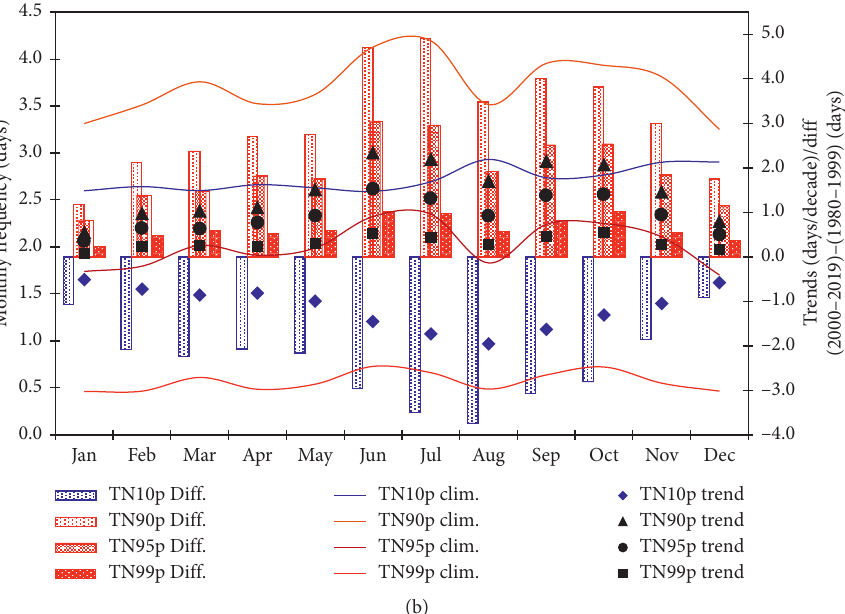
Figure 13: The annual cycle of the country-averaged warm and cold indices along with linear trends for the period 1978–2019. The percentile-based indices are TX10p, TX90p, TX95p, TX99p, TN10p, TN90p, TN95p, and TN99p, along with their differences for the warmer (2000–2019) and colder (1980–1999) periods. Solid red and blue lines represent the climatology for TX-indices and TN-indices, respectively. (a) TX; (b)